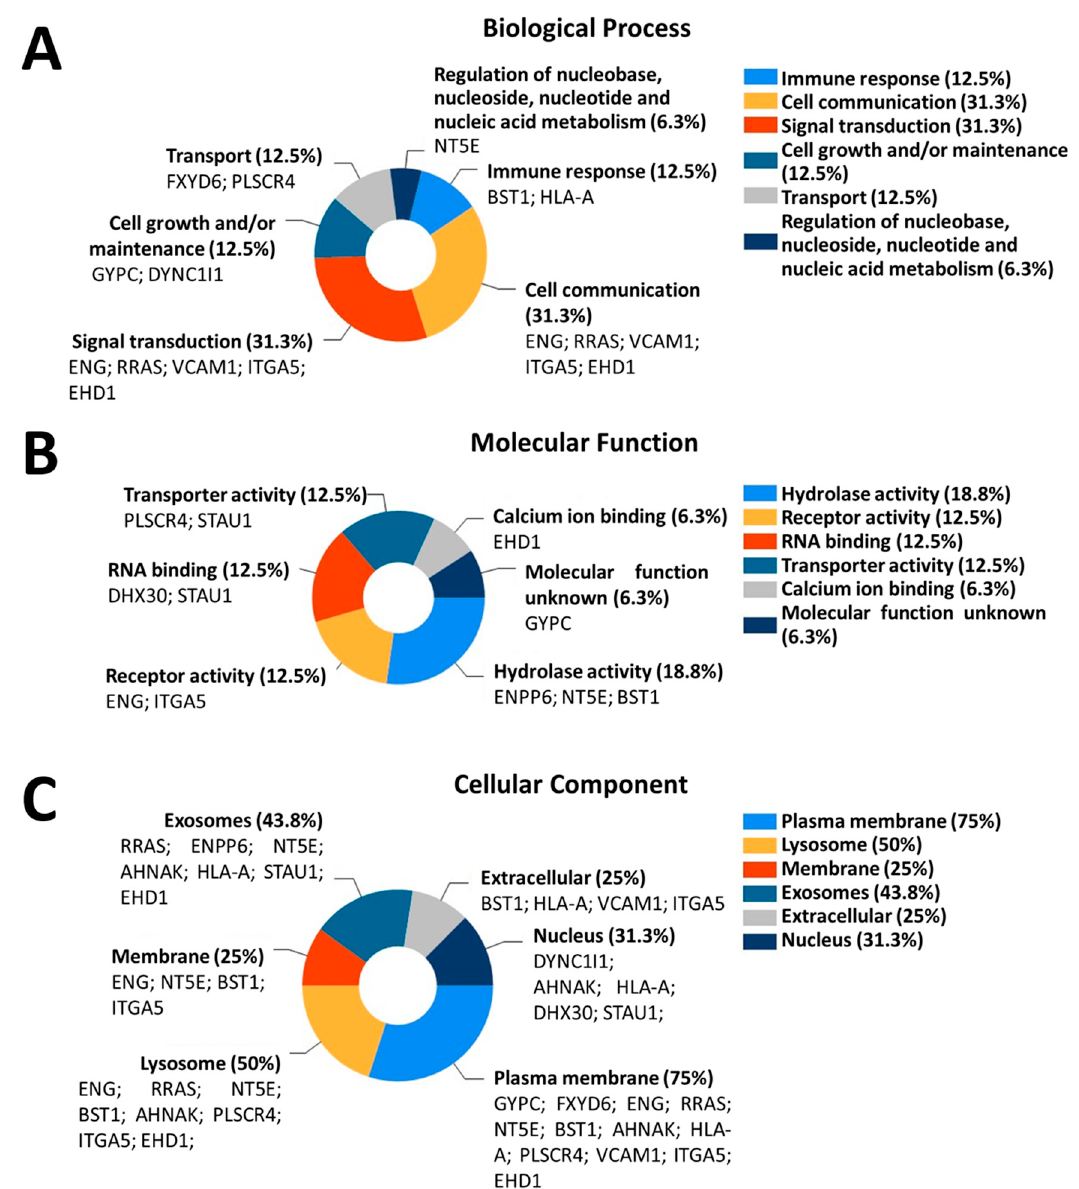
Figure 5. GO enrichment of the 16 proteins found to be differentially packaged in ALS MCEVs compared to NC MCEVs. ( A ). Biological process: The differentially expressed proteins appear to be involved mainly in cell communication and signal transduction. ( B ). Molecular function: The differentially expressed proteins appear to exhibit hydrolase activity, receptor activity, RNA-binding and transporter activity. ( C ). Cellular component: The differentially expressed proteins appear to be overwhelmingly sequestered to the plasma membrane, followed by lysosome and exosomes. Graphs were created on FunRich3.1.3 [49].